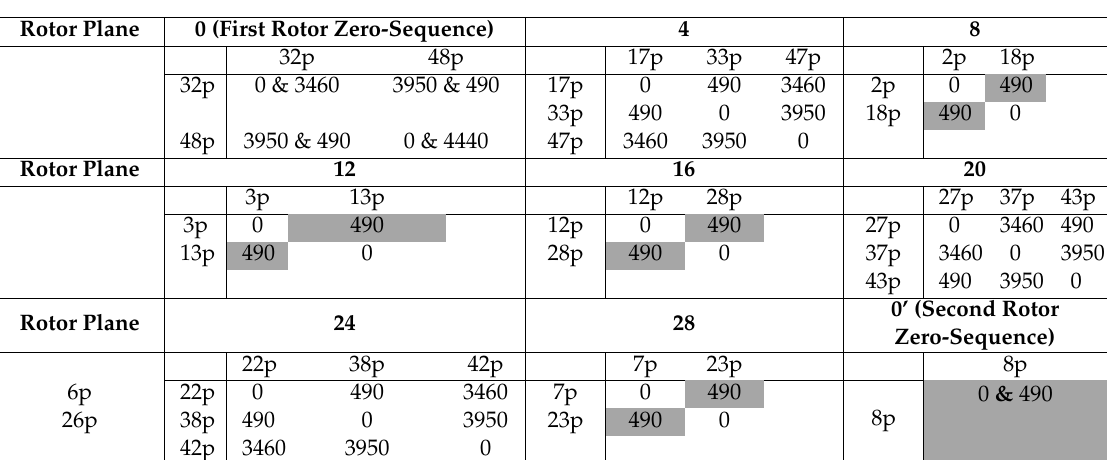
Table 7. Predicted torque pulsating components frequencies for the five-phase IM with 64 bars (in Hz). Sequence “u =